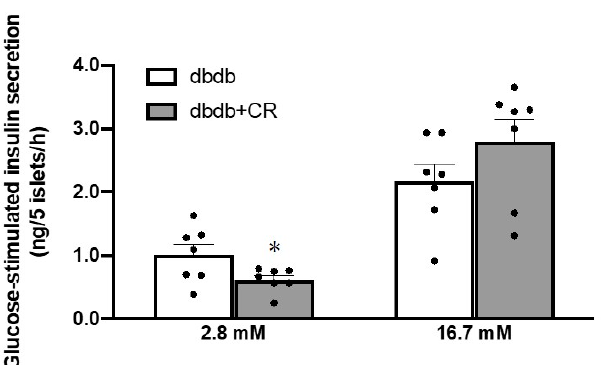
Figure 4. Effects of calorie restriction on glucose-stimulated insulin secretion in db/db mice. dbdb, ad libitum-fed control group; dbdb+CR, daily calorie restriction group. Data of misty mice were used as reference values (dotted lines). Data are the mean ± SEM ( n = 7). * p < 0.05 compared with the dbdb group.